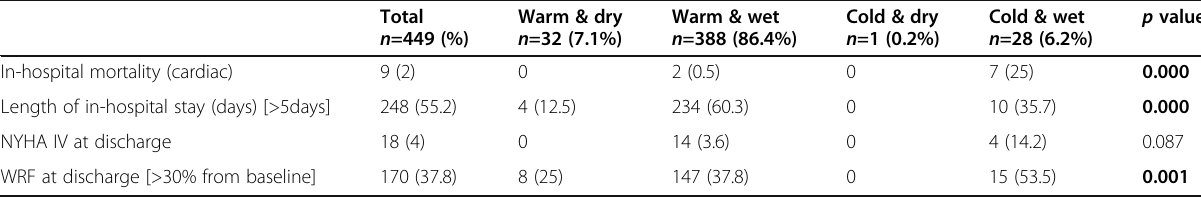
Table 4 In-hospital outcome: based on clinical phenotypes (univariate analysis)